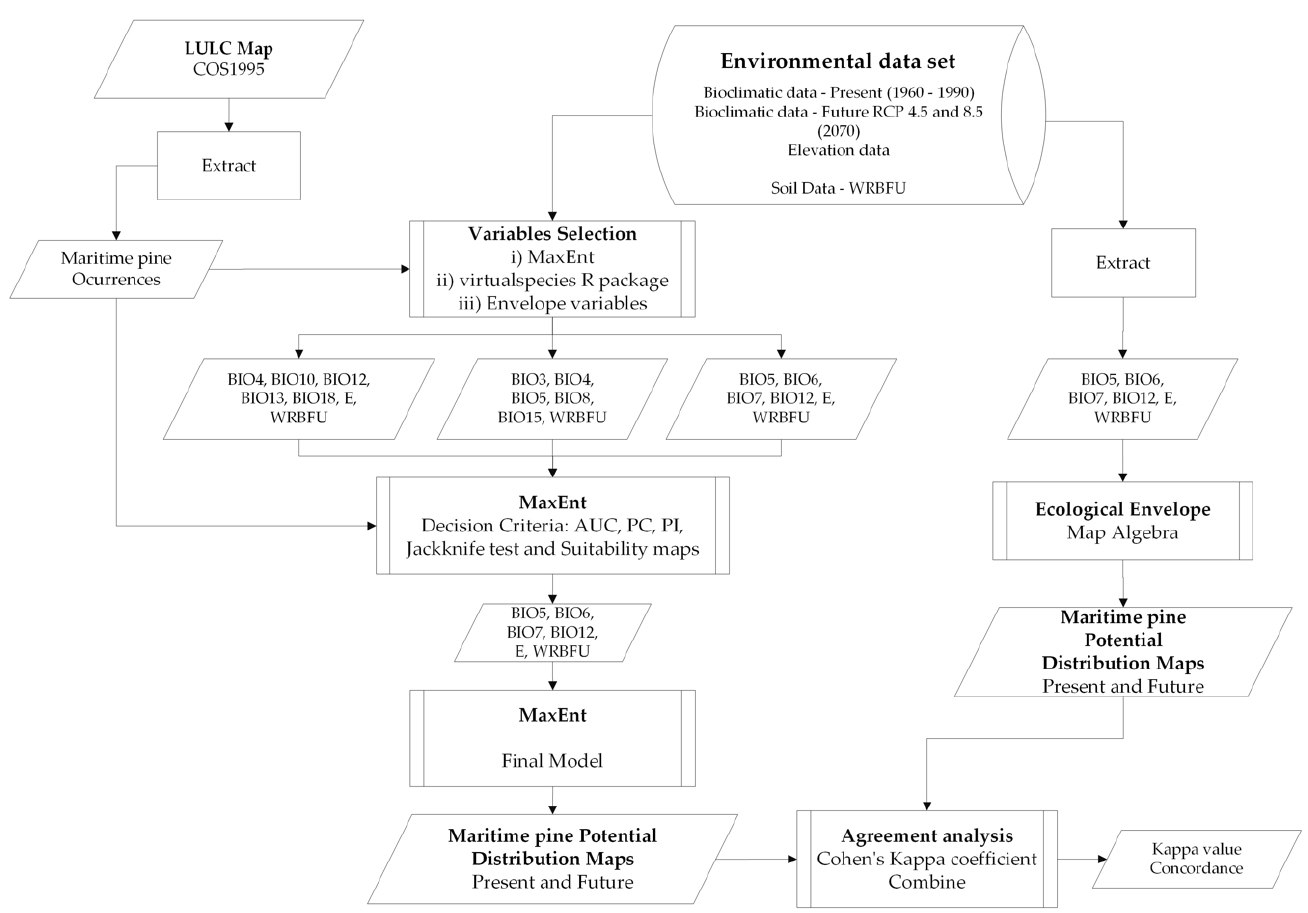
Figure 4. GIS workflow for the species distribution maps production by the two methodological approaches (MaxEnt and ecological envelope) and agreement analysis between them.